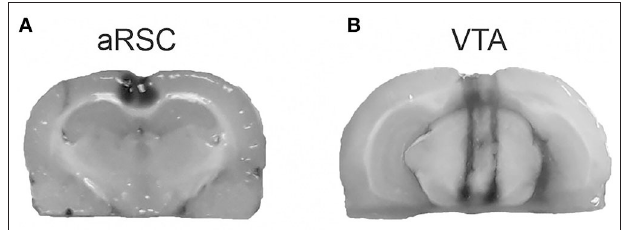
FIGURE 1 | Representation of the infusion area. Pictures show the methylene blue infusions area (black) for aRSC (A) and VTA (B) .